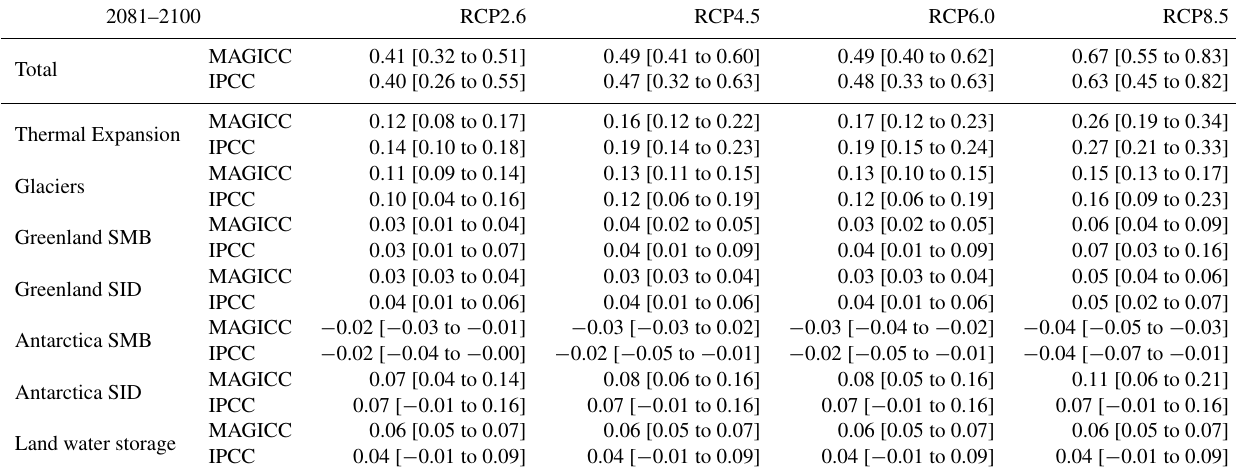
Table 6. The 2081–2100 median values and 66% ranges for global SLR projections relative to 1986–2005 in meters, resolved by sea level components for the four RCP scenarios. Estimates are provided based on the CMIP5-consistent MAGICC setup. IPCC median projections and likely ranges are given as a reference.